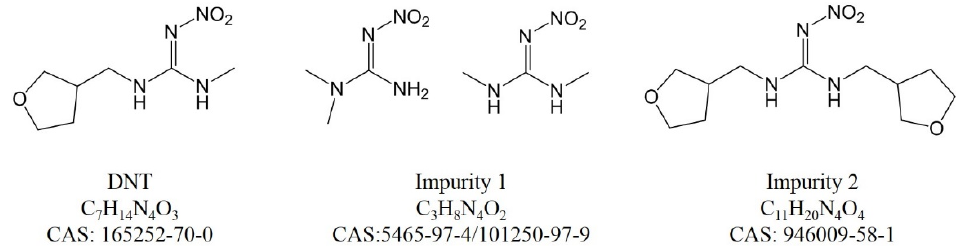
Figure 2. Chemical structures of DNT and impurities.